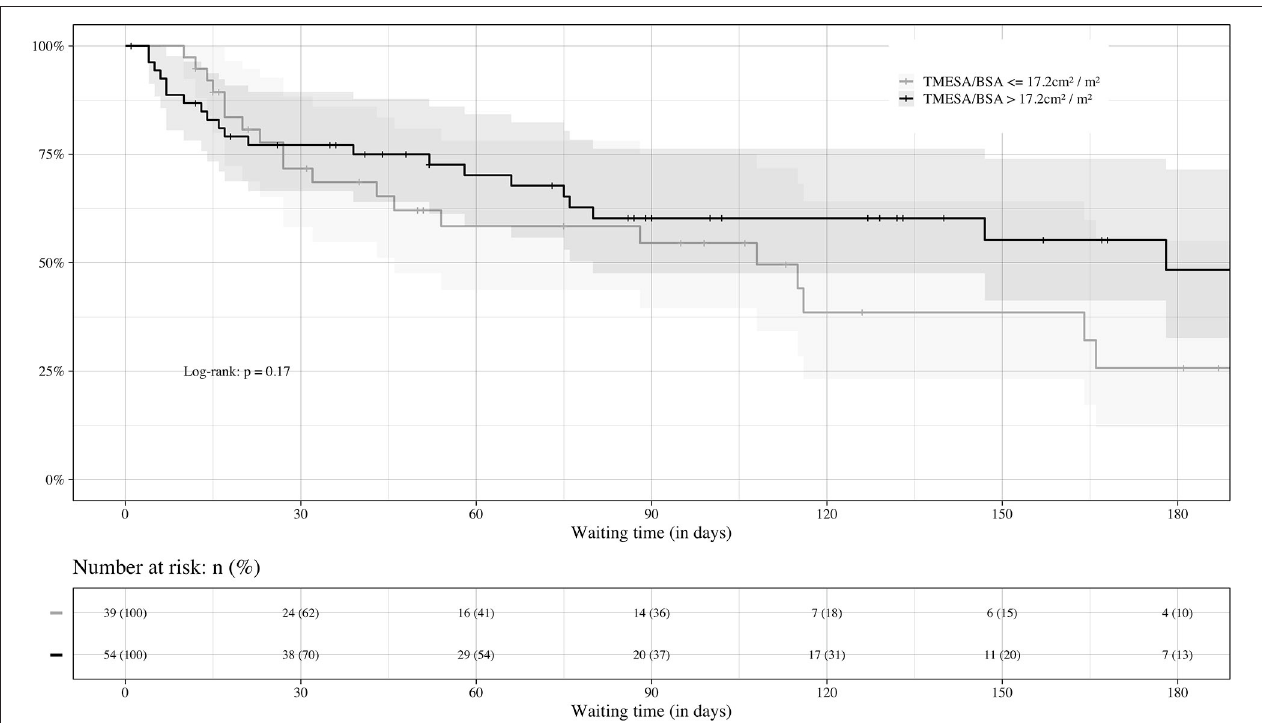
FIGURE 5 | Prognosis of waiting time in regard of sarcopenia. Impact of muscle mass on the course of HU waiting time. Event: death or emergency VAD implantation during the HU waiting time, censored: heart transplantation. VAD, ventricular assist device; TMESA/BSA, total area of the erector spinae muscles/body surface area; HU, high